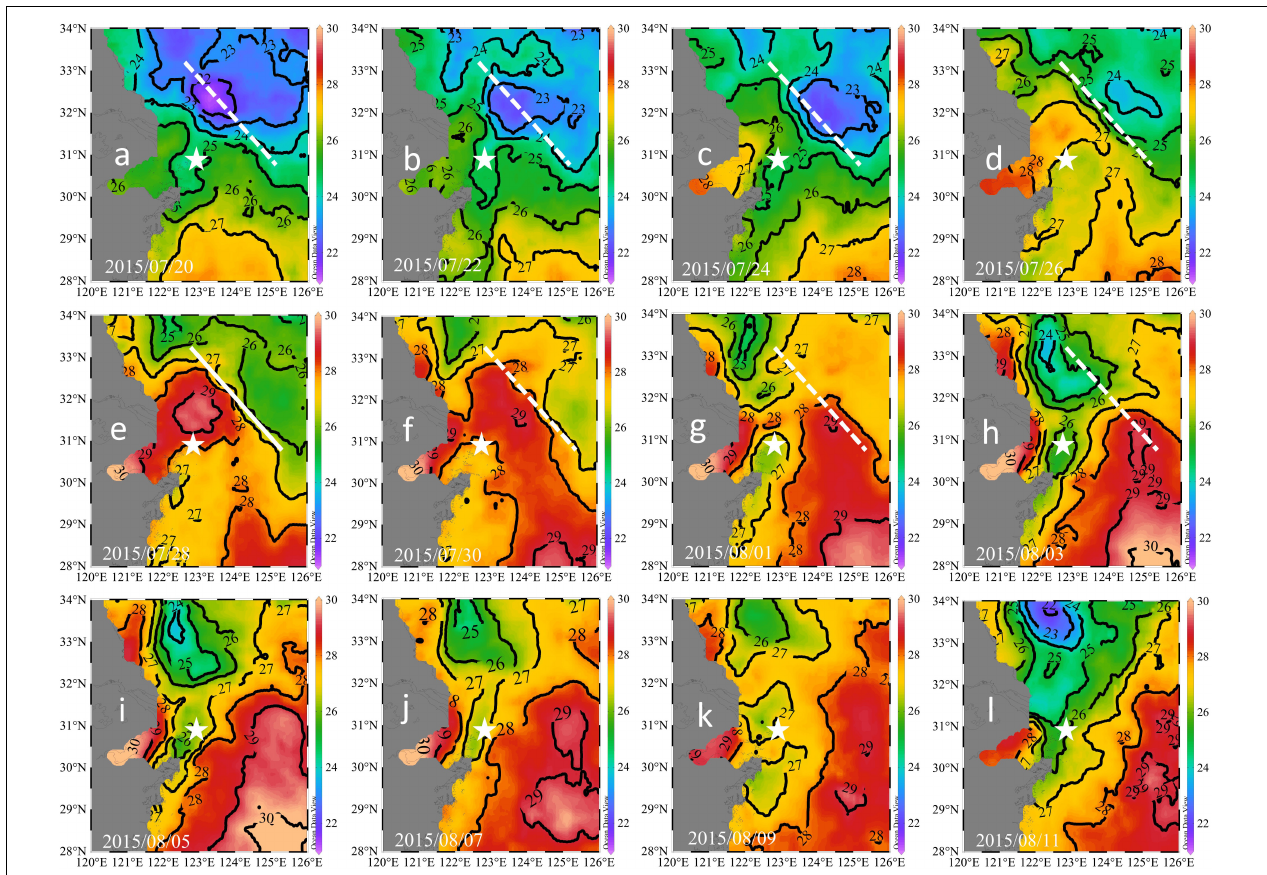
FIGURE 5 | Remotely-sensed sea surface temperatures during July 20 to August 11, 2015: 07/20 (a) , 07/22 (b) , 07/24 (c) , 07/26 (d) , 07/28 (e) , 07/30 (f) , 08/01 (g) , 08/03 (h) , 08/05 (i) , 08/07 (j) , 08/09 (k) , and 08/11 (l) . The white lines denote the location of the thermal front on July 28. The buoy location is shown by